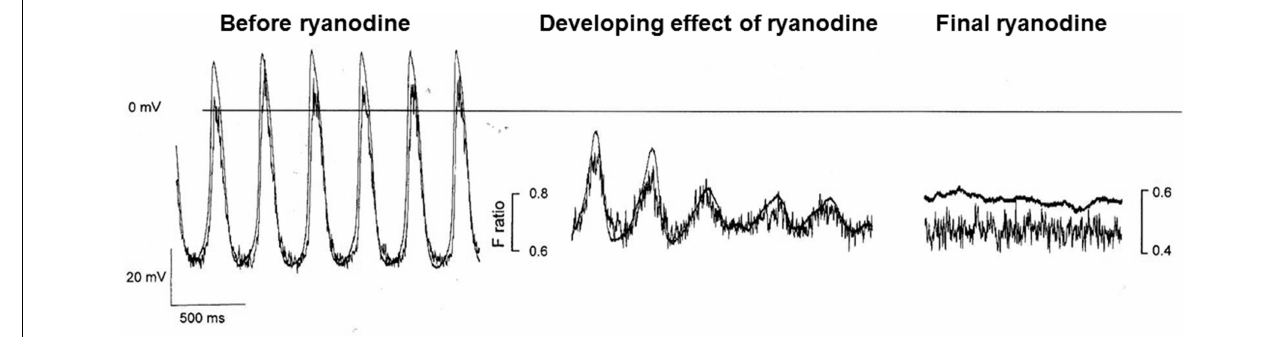
FIGURE 3 | This figure shows the effect of ryanodine in a pacemaker cell in the presence of the calcium probe indo-1 and isoprenaline. Although in our experience, ryanodine slows but does not normally stop spontaneous activity, we have observed cessation of activity after ryanodine when calcium probes are present, particularly those with a high Ca 2 + affinity, and we have attributed this to the additional Ca 2 + buffering effects of the probe (see text). Despite these limitations, the trace is instructive in that before